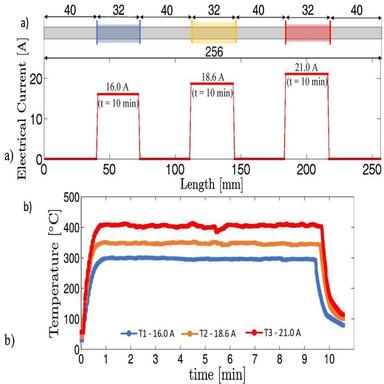
Heat treatment plan for a FGM with 3 different customized regions: a) Parameters of the heat treatment. b) Temperature history in the midpoint of each heat treated segment obtained via infrared camera.